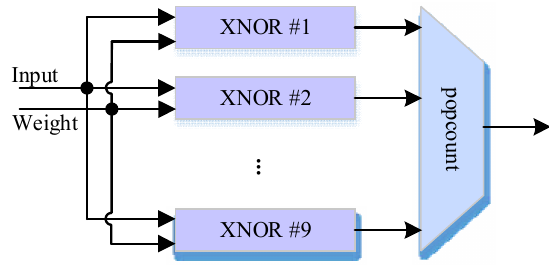
Figure 3. The Shared PE architecture.